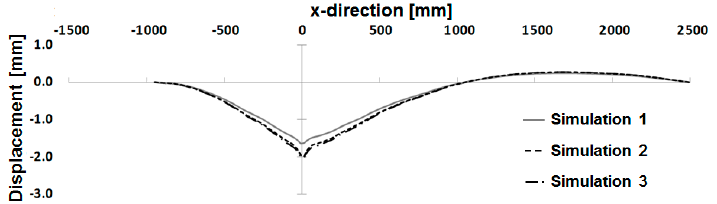
Figure 23. Simulation results (displacement in x-direction y=6600 mm).